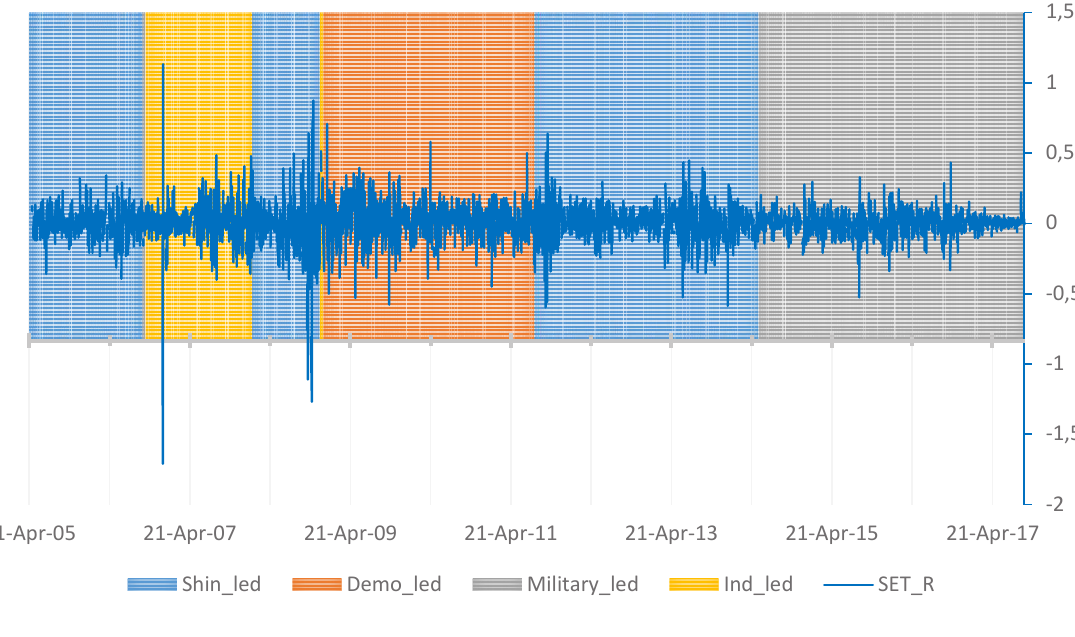
Figure 2. Thai Government and returns of SET index (SET_R, scaled by 10)